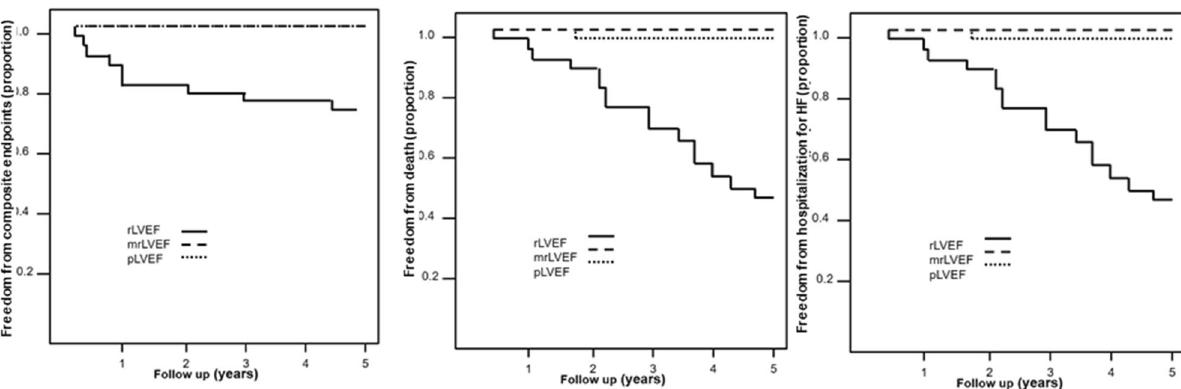
Figure 2. Composite endpoints (hospitalization for HF, complex ventricular arrhythmias, heart transplant and death), survival and hospitalization for heart failure Kaplan Meyer curves are shown for the three groups. HF heart failure, rLVEF reduced left ventricular ejection fraction, mrLVEF mid-range or mildly ejection fraction, pLVEF preserved left ventricular ejection